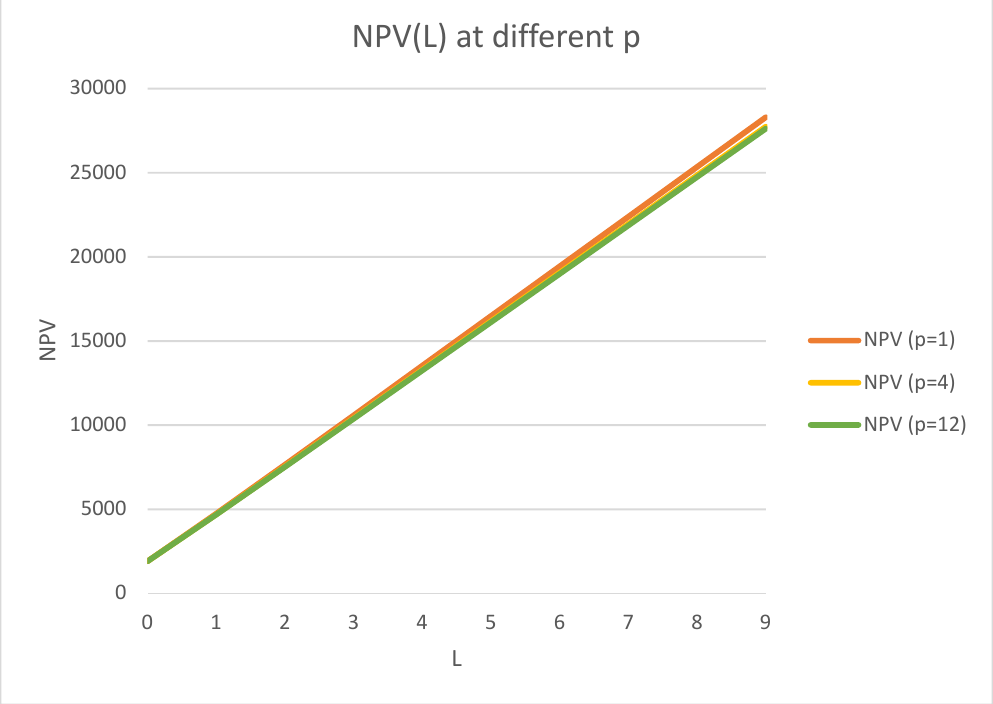
Figure 8. Change of net present value, NPV, with leverage, L , for k d = 0.14, k 0 = 0.22, and p = 1, 4, and 12, for a perpetuity project.